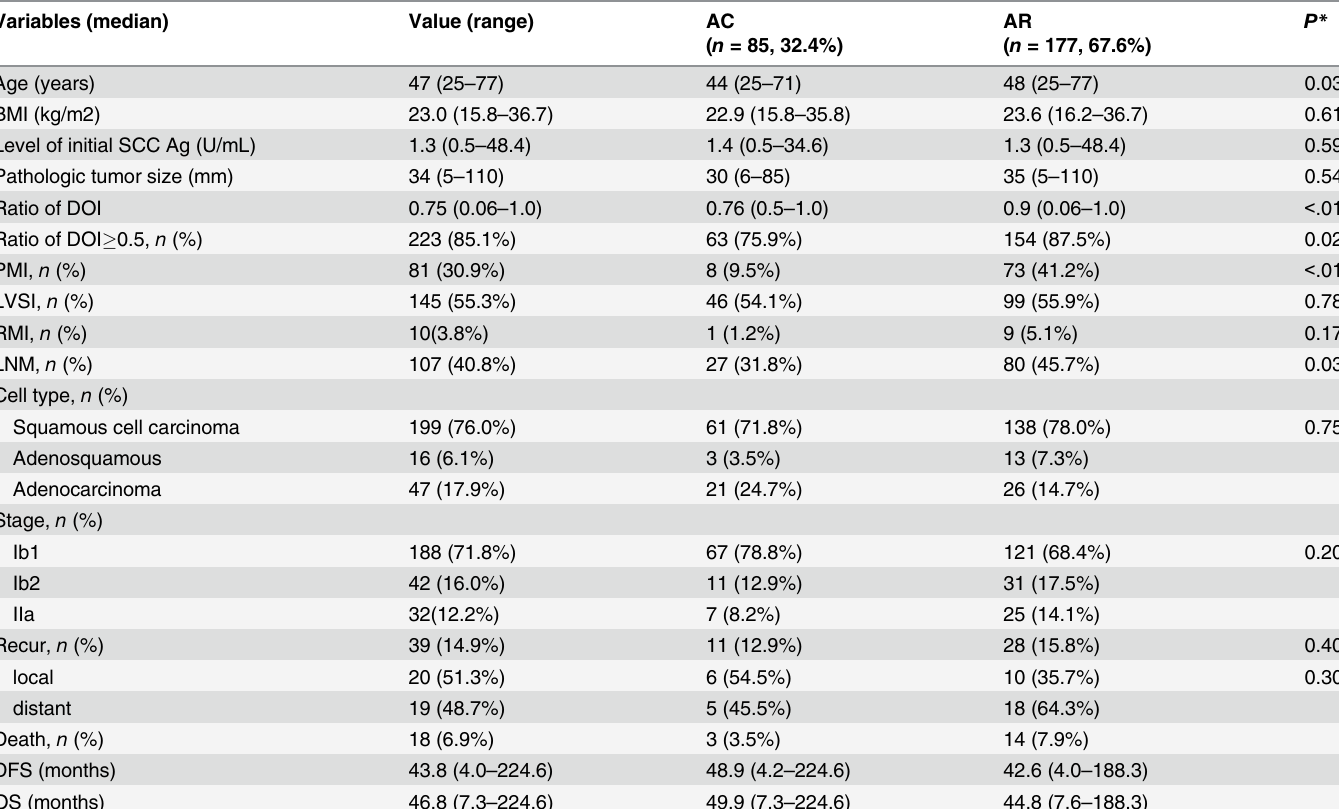
Table 1. Baseline characteristics and comparison of the study patients in the AC and AR treatment